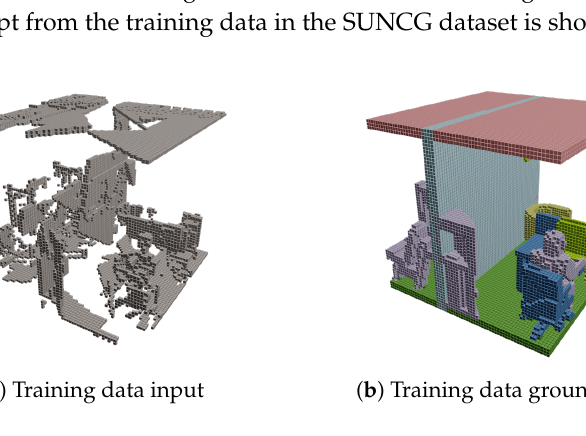
Figure 7. Excerpt of the training data in the SUNCG